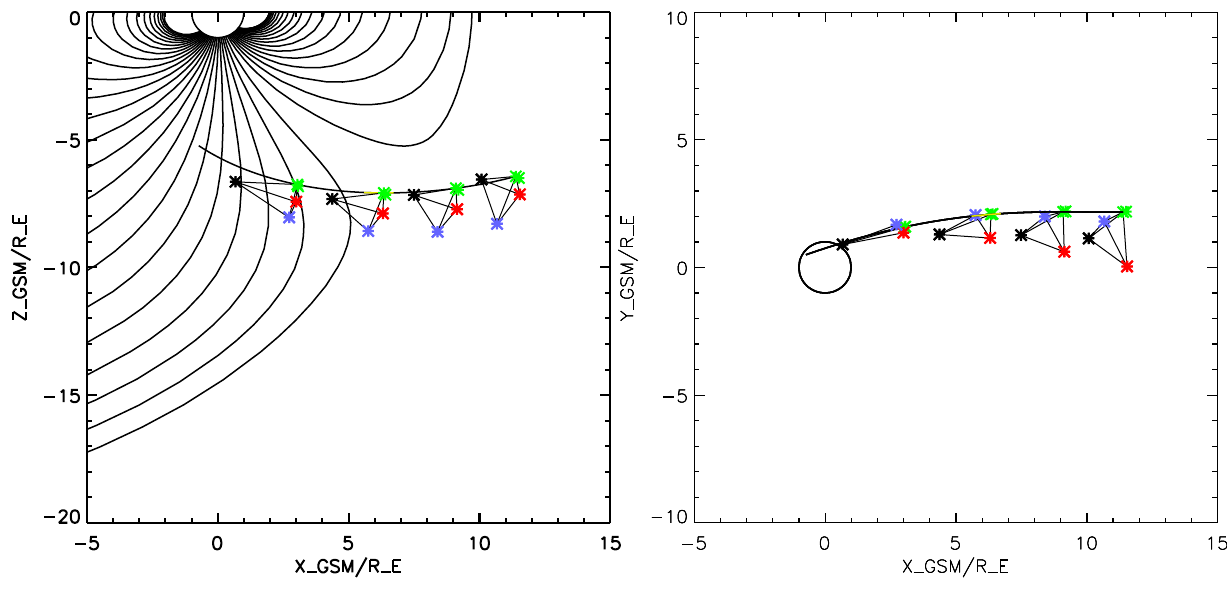
Fig. 1. The Cluster orbit between 16:00 and 23:59UT on 13 February 2001 in the x-z GSM plane (left panel) and x-y GSM plane (right panel). The spacecraft are colour-coded (black, red, green and blue for spacecraft 1–4, respectively). The spacecraft are first shown at 16:00 and then at two hour intervals. T89 model field lines are shown in Fig. 1a. The spacecraft separations shown are 20 times larger than in reality, with spacecraft 3 being shown at its real